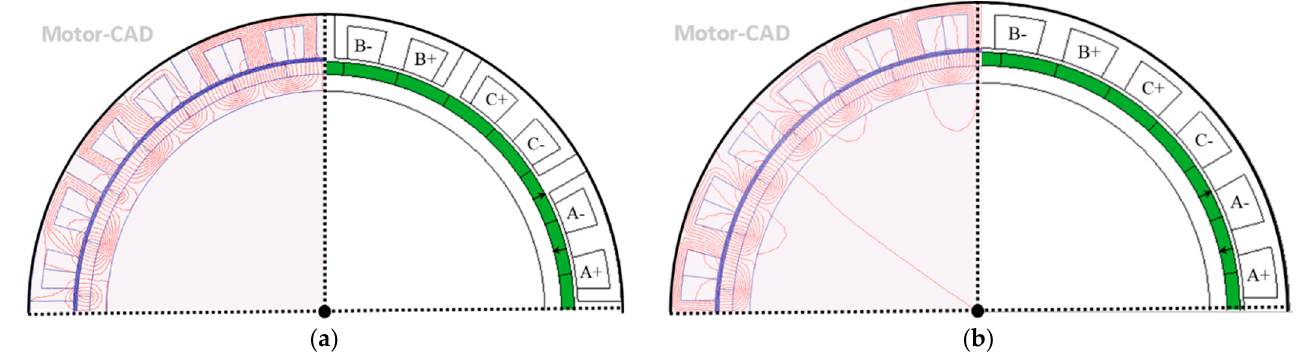
Figure 1. Cross sections and open-circuit flux line distribution of SPM machines: ( a ) modular machine; ( b ) non-modular machine.